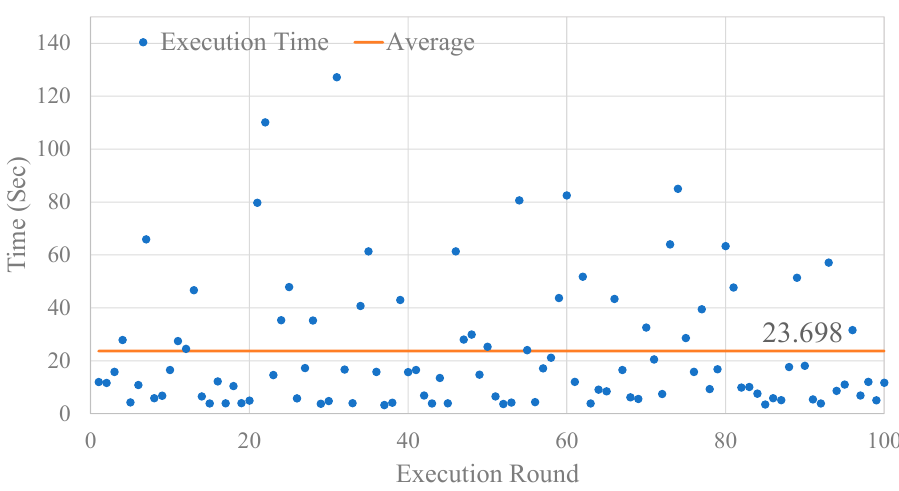
Figure 10. Data contribution processing time in each round for the Ethereum part.